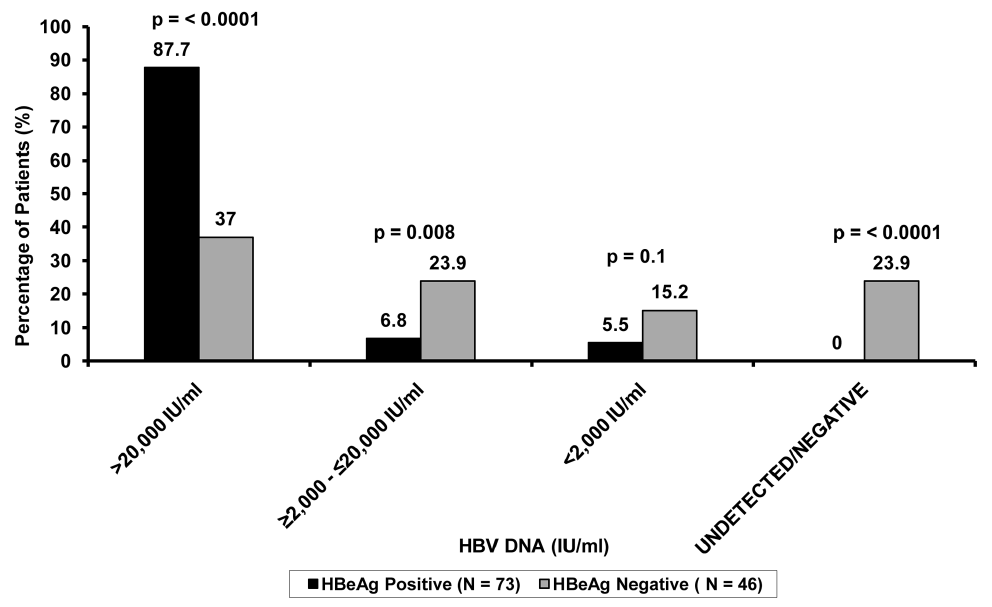
Figure 1. Comparison between HBeAg positive and HBeAg negative subjects with respect to varying HBV DNA levels. Major proportion of HBeAg positive subjects were associated with higher HBV DNA levels compared to HBeAg negative subjects.